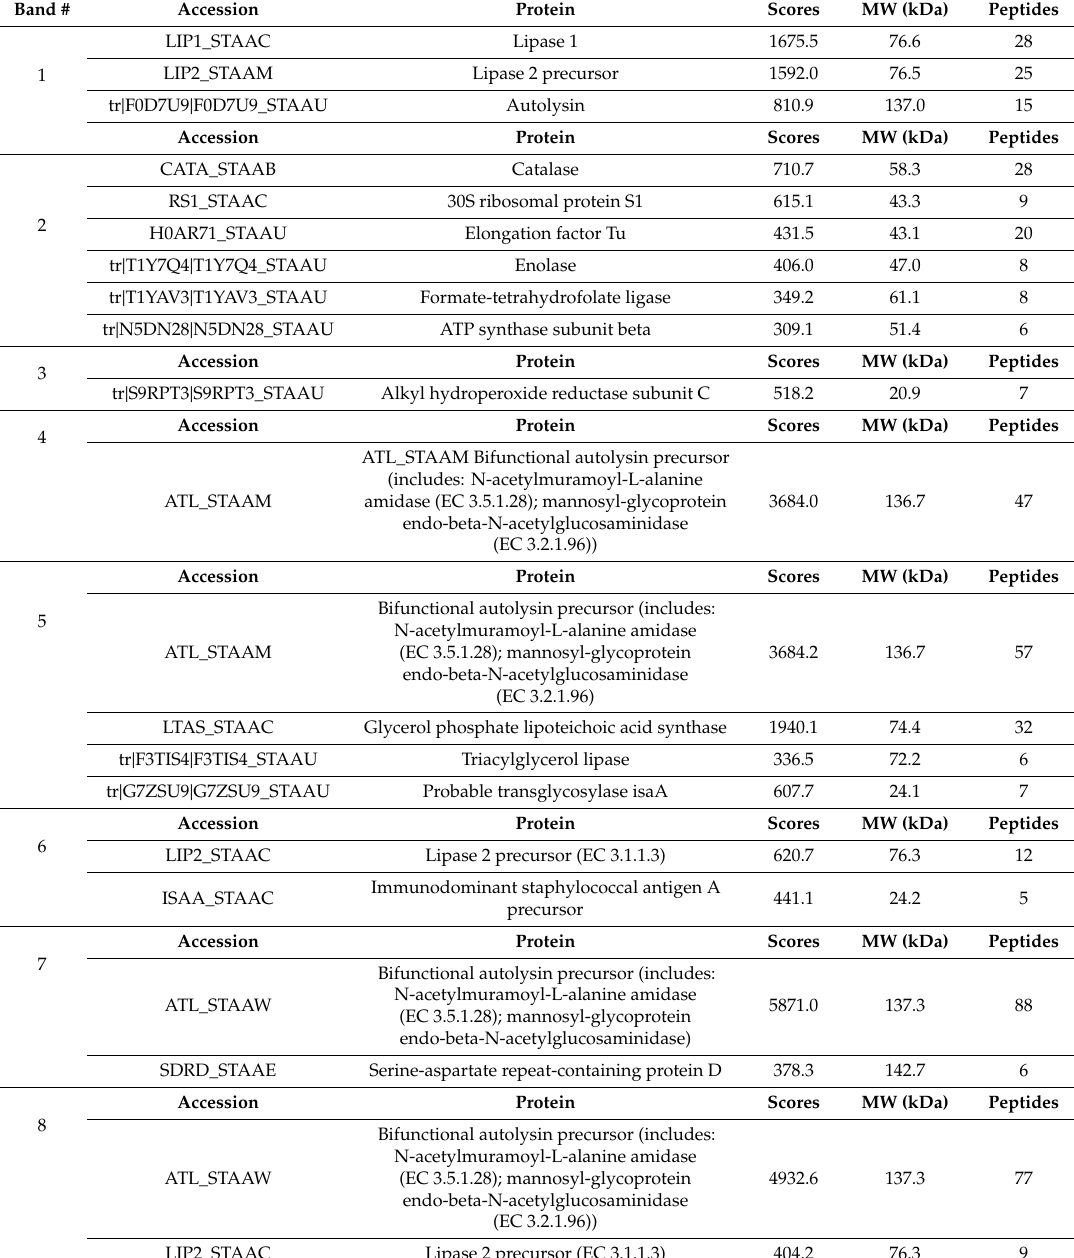
Identified proteins within the bands that varied in abundance between the strains and